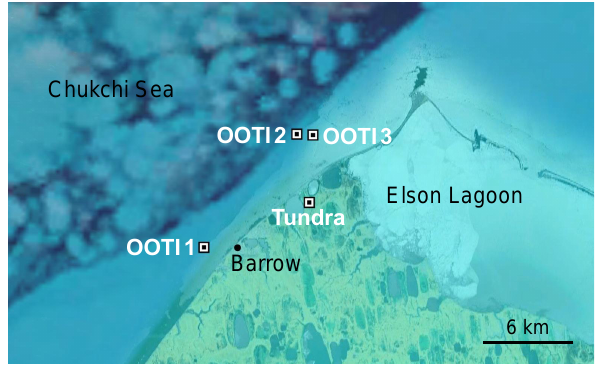
Figures Figure 1a: Field experimental sites around Barrow located near the northernmost tip of Alaska. OOTI Site 1 at 71.29 o N; 156.85 o W, OOTI Site 2 at 71.36 o N;156.69 o W, OOTI Site 3 at 71.36 o N;156.66 o W and Tundra at 71.32 o N;156.66 o W. The MODIS Aqua satellite is translucently overlain to show sea ice conditions in the Chukchi Sea on March 19, 2009.